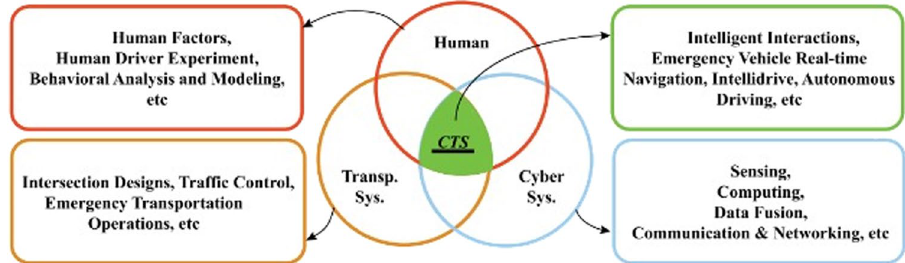
Fig. 3 CPSS-based Transporta- tion System